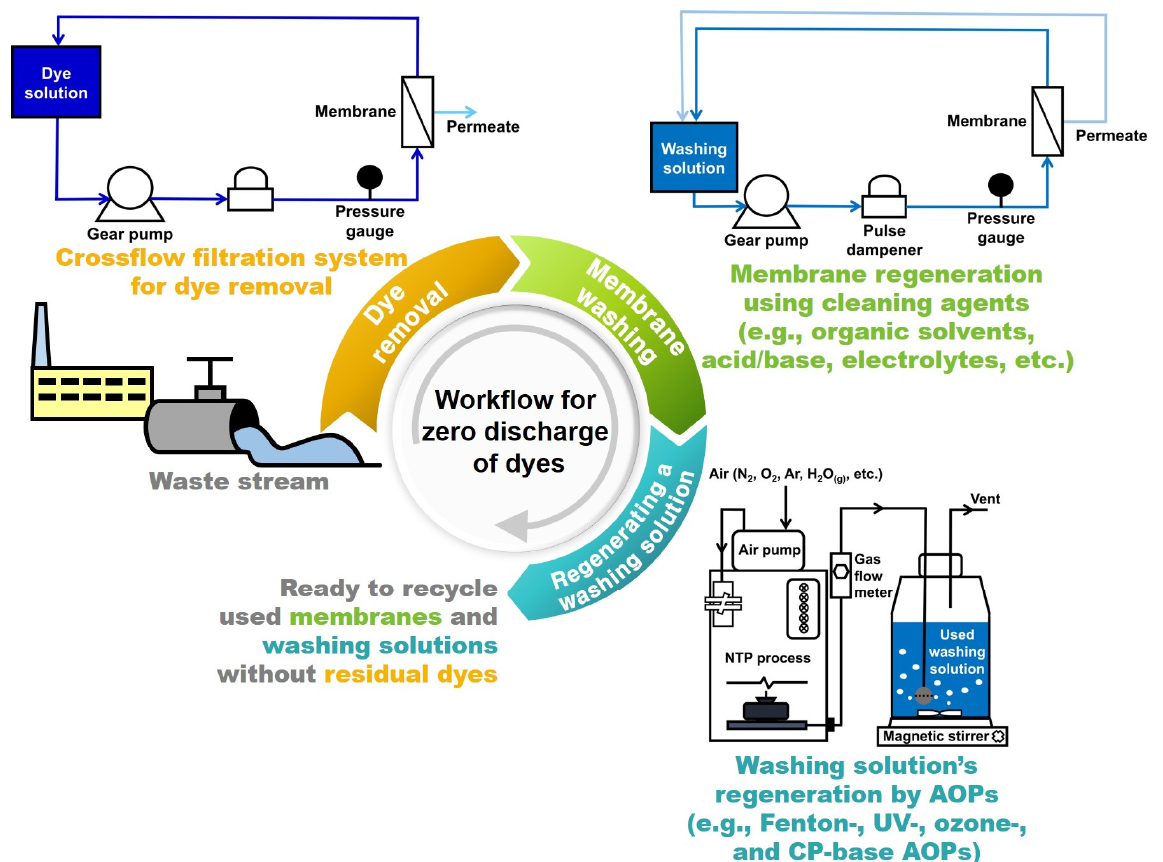
Figure 6. Conceptual illustration of the workflow for zero discharge of dyes in a membrane-based dye removal process via membrane regeneration using various kinds of cleaning agents, such as organic solvents, acid/base, and electrolytes, along with washing solution’s regeneration by diverse AOPs, such as Fenton-, UV-, ozone-, and CP-based